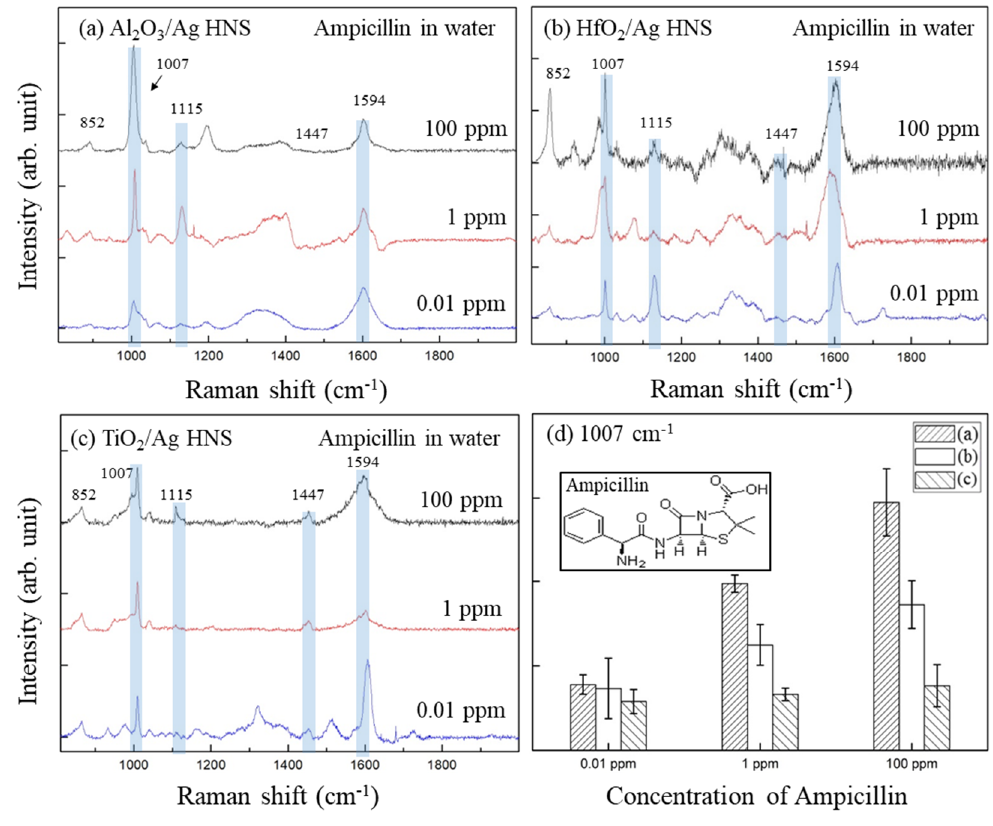
Figure 5. Examples of SERS spectra of ampicillin in water with respective concentrations of 100, 1.0, and 0.01 ppm upon ( a ) Al 2 O 3 /, ( b ) HfO 2 /, and ( c ) TiO 2 /Ag HNS. By taking different characteristic peaks: 1007, 1115, and 1447 cm −1 in different concentrations of ampicillin in water. Relative intensities of the peak at 1007 cm −1 were respectively compared with respect to dielectric type and ampicillin concentration ( d ), ( n = 5).